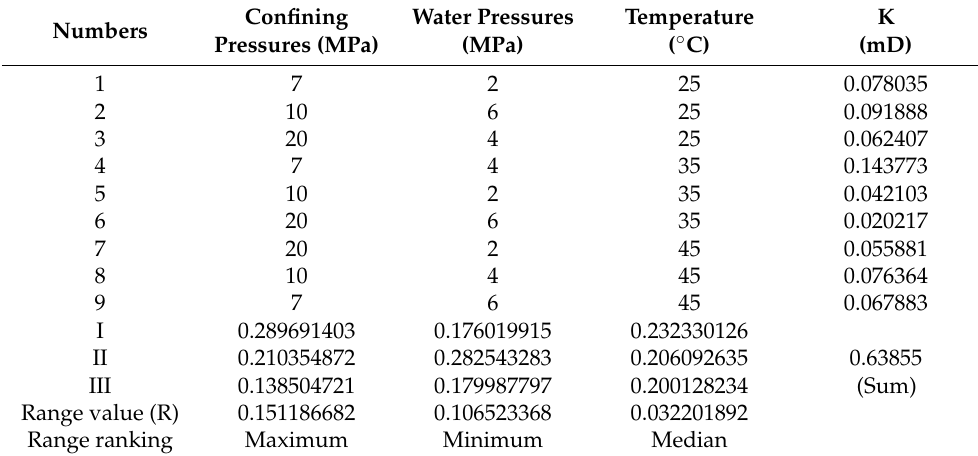
Table 6. Analysis of orthogonal test results for subcategory I 2